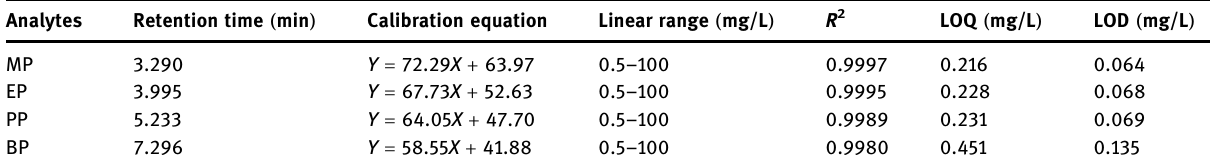
Table 2: The analytical performance data for HPLC system Analytes